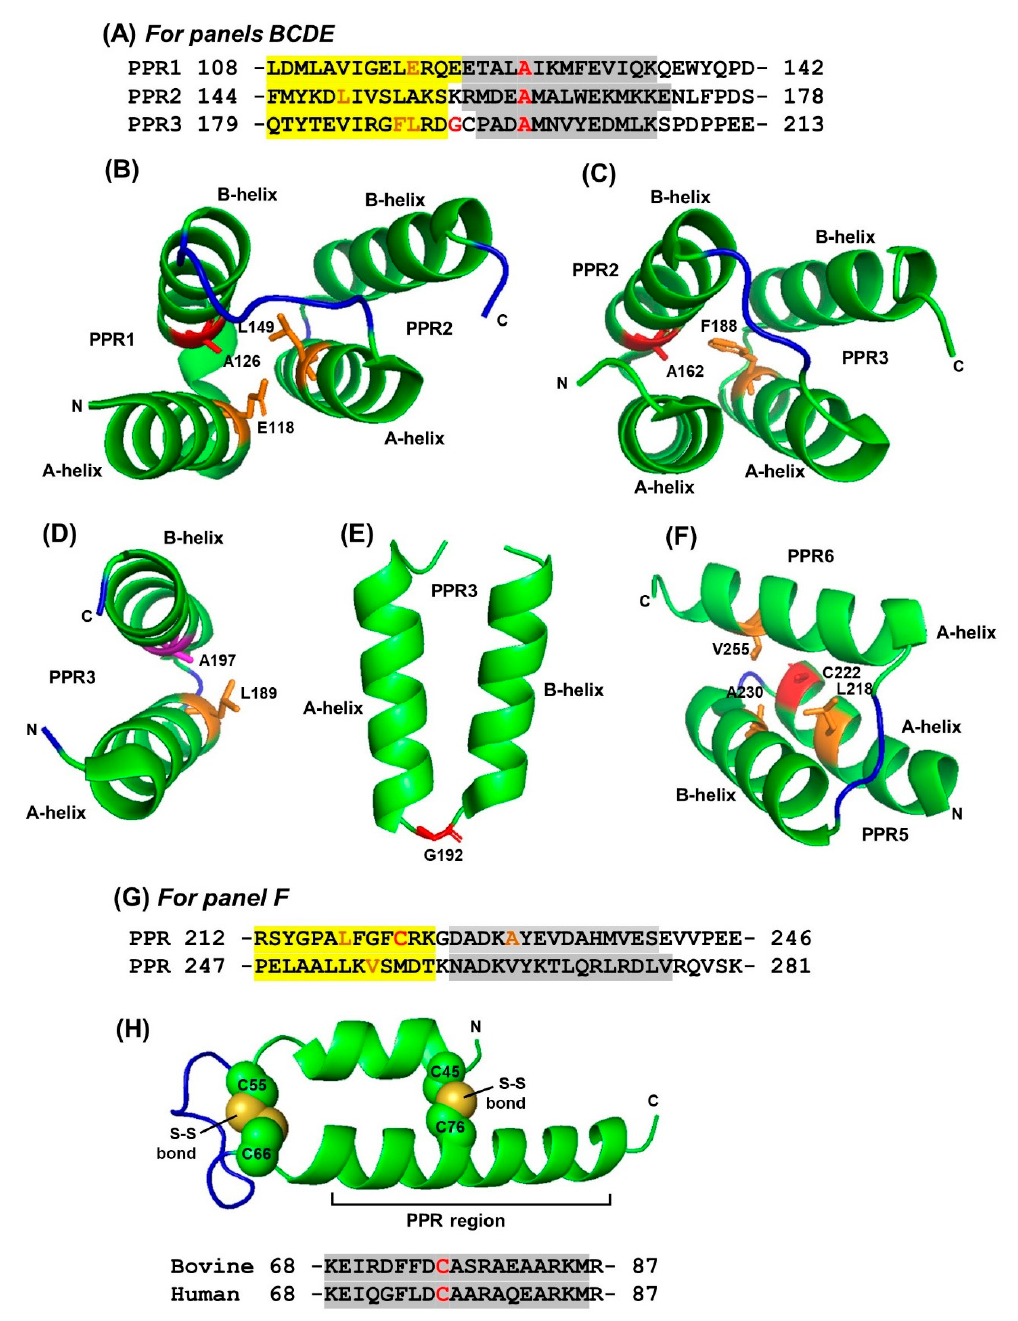
Figure 2. Interaction between the side chains of selective amino acid residues in pentatricopeptide repeats (PPRs). The 3D structures displayed by PyMol in panels ( B – F , H ) correspond to the amino acid sequences in panels ( A , G , H ), as labeled (details in Results). A-helix and B-helix sequences are shaded yellow and grey, respectively. The sequence in panel ( A ) is a set of three-PPR repeats in the Arabidopsis thaliana ‘thylakoid assembly 8-like protein’ found in the chloroplast (GenBank Q9STF9; PDB 4LEU). In each repeat, the invariant A20 residue and a glycine are in red color, and the major residues that the interact with are in orange, as shown in the panels ( B – E ). Panel ( G ) shows two tandem PPRs in proteinaceous Ribonuclease P1, also from a six-PPR domain in Arabidopsis thaliana chloroplast (Q66GI4), corresponding to the structure in panel ( F ) (PDB 4G24). Panel ( H ) shows the part of a unique CHCH/PPR domain conserved in bovine and human, which is involved in two pairs of intramolecular Cys-Cys disulfide bonds as shown (details in Results, Section